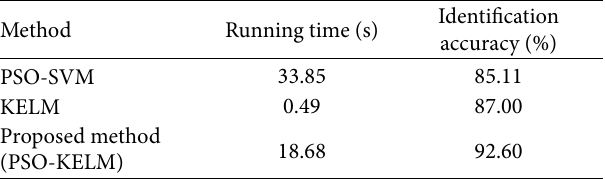
Table 1: The comparison table of testing results of three methods.